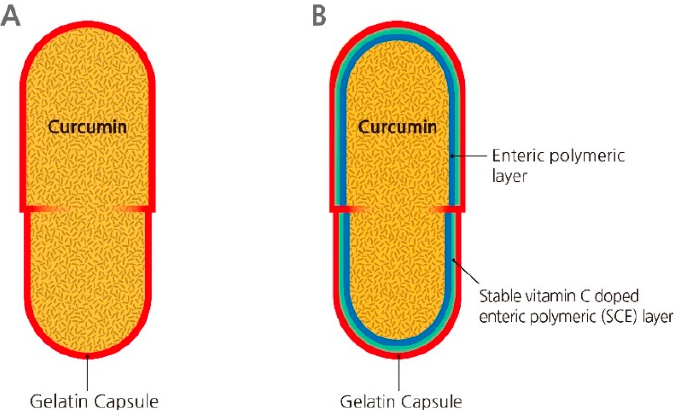
Figure 1. Schematic description of the proposed 3- O -ethyl-L-ascorbic acid (EA) doped enteric- coated gelatin capsule. ( A ) a capped gelatin capsule, and ( B ) a capped EA doped enteric-coated gelatin capsule.